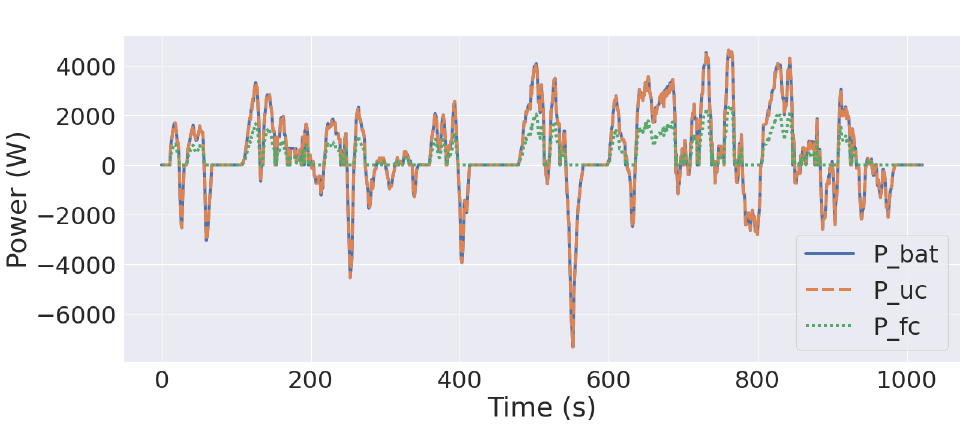
Figure 11. Battery, ultracapacitor and fuel cell powers by rule-based optimization.